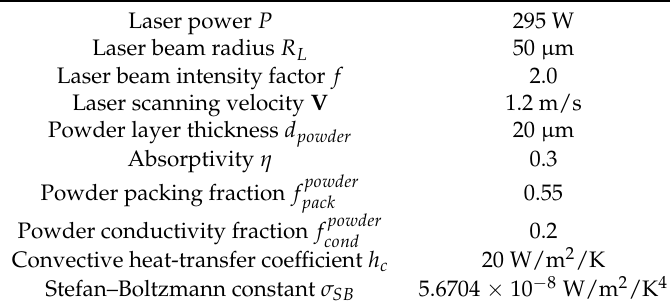
Table 1. Assumed large-scale heat-transfer model